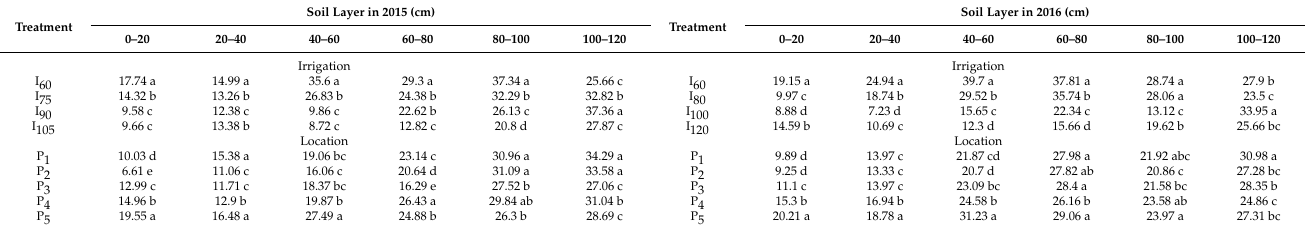
Table 2. Average NO 3 − -N content at different locations in different irrigation and fertigation treatments. SoilLayerin2015(cm) Treatment